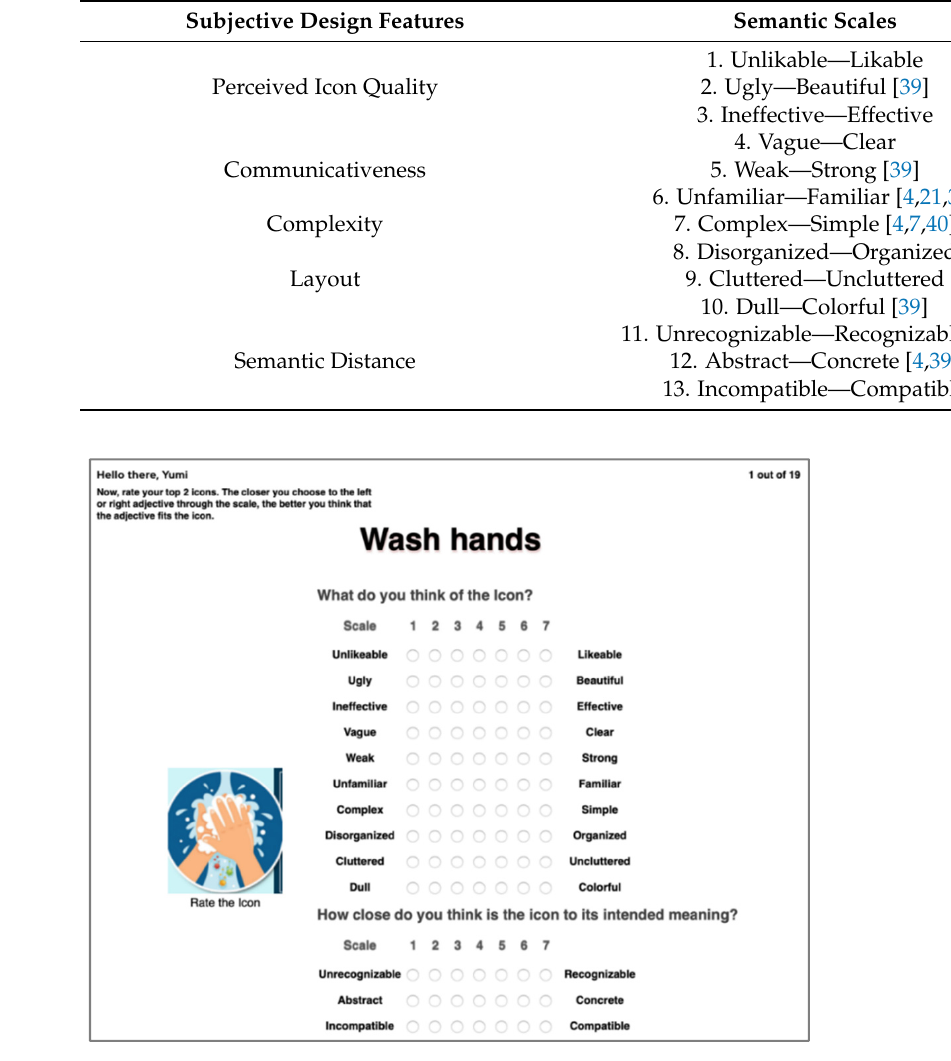
Figure 3. Example of subjective design feature test